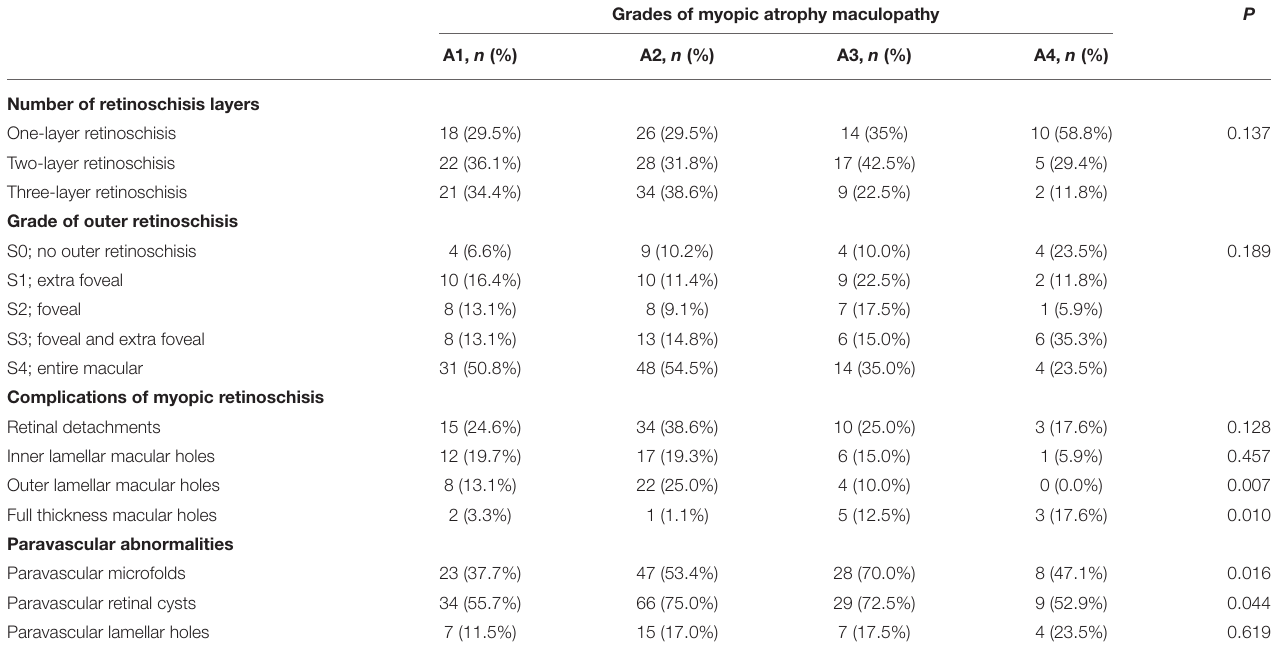
TABLE 2 | Characteristics of myopic tractional maculopathy in different grades of myopic atrophy maculopathy. Grades of myopic atrophy maculopathy